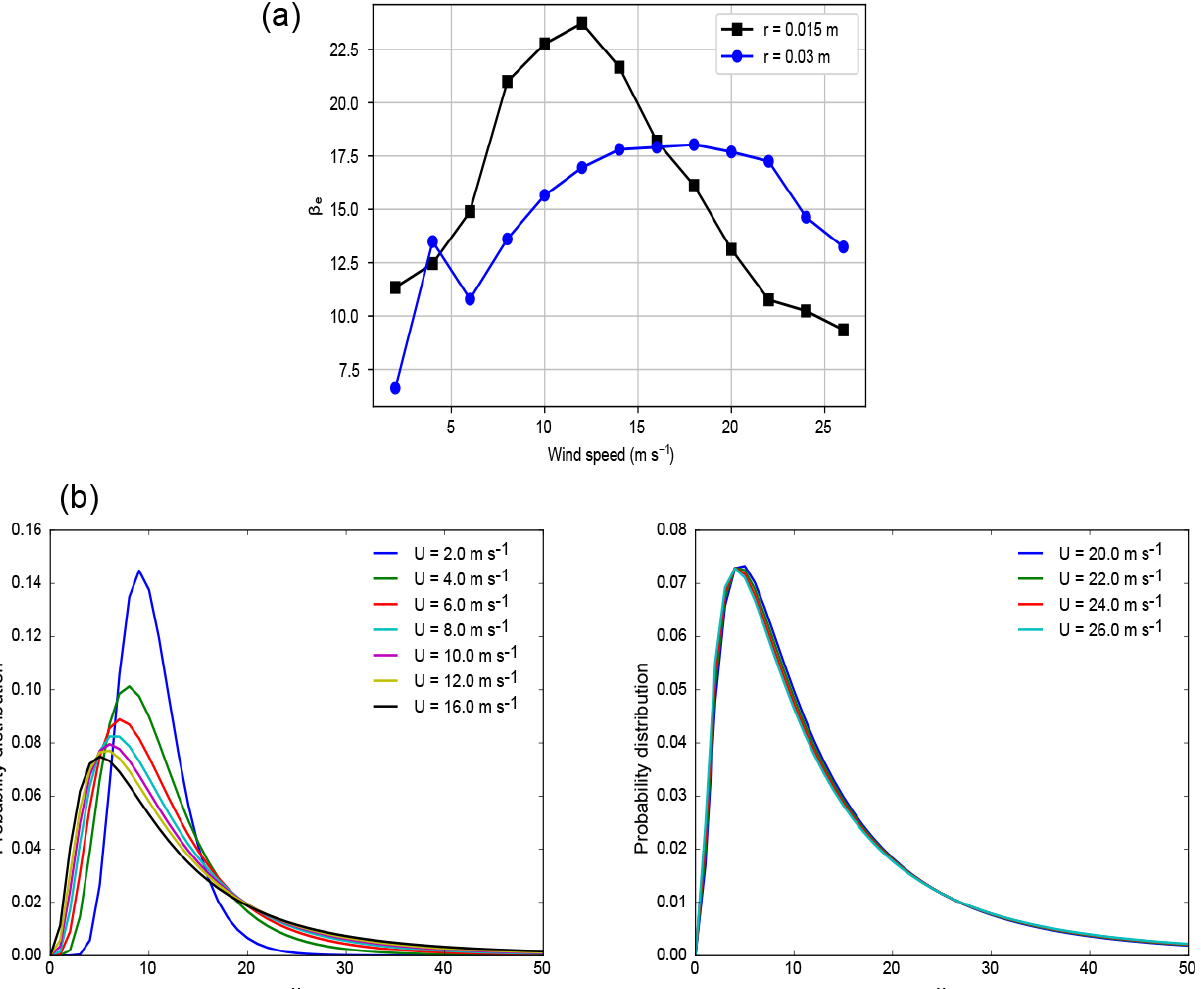
Figure 6. (a) Line plot showing the sensitivity of the formulation to different wind conditions and radii when the fire intensity is constant (50MWm − 1 ). The measure of the effective increase in area ( β e ) and other simulation parameters are the same as defined in Fig. 5. (b) The line plots show the lognormal distribution for selected values of wind speed U but constant values of fire intensity I = 5000kWm − 1 and firebrand radius r = 0 . 03m. According to the physical parameterisation, the plots can also be interpreted as the behaviour of the lognormal distribution for varying values of the parameter σ and a constant value of the parameter µ